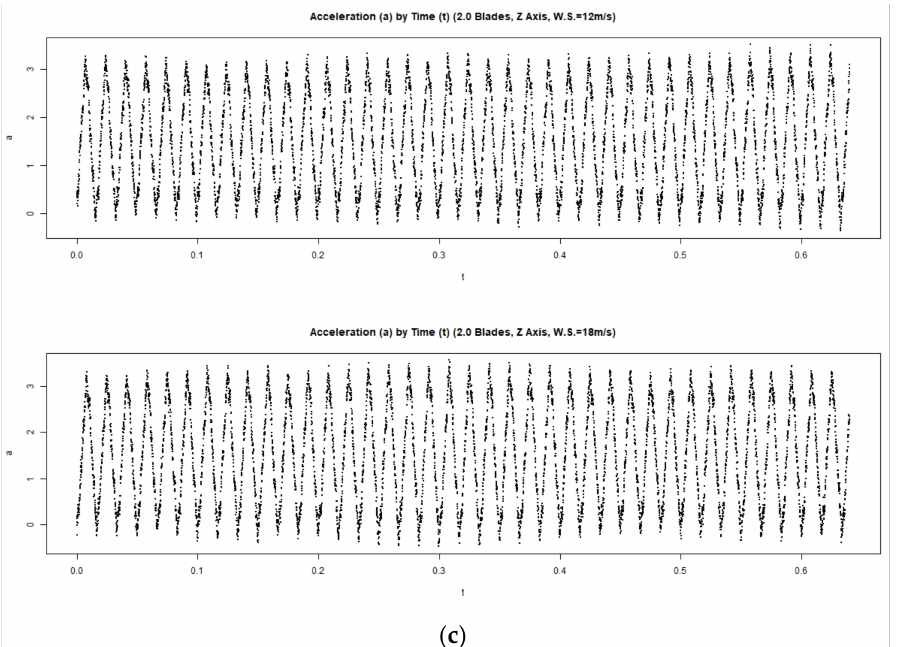
Figure A3. Acceleration signals recorded for the 2.0-blade (one blade missing) turbine. ( a ) Data recorded along the X axis with different wind-speeds imposed. ( b ) Data recorded along the Y axis with different wind-speeds imposed. ( c ) Data recorded along the Z axis with different wind- speeds